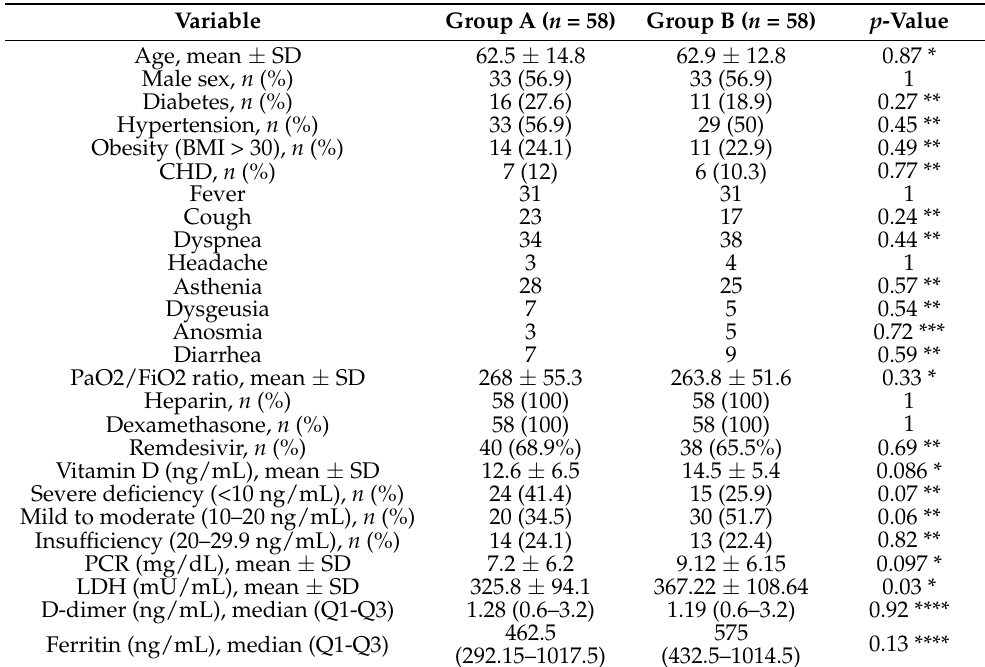
Table 1. Baseline characteristics among patients included in our matched-cohort